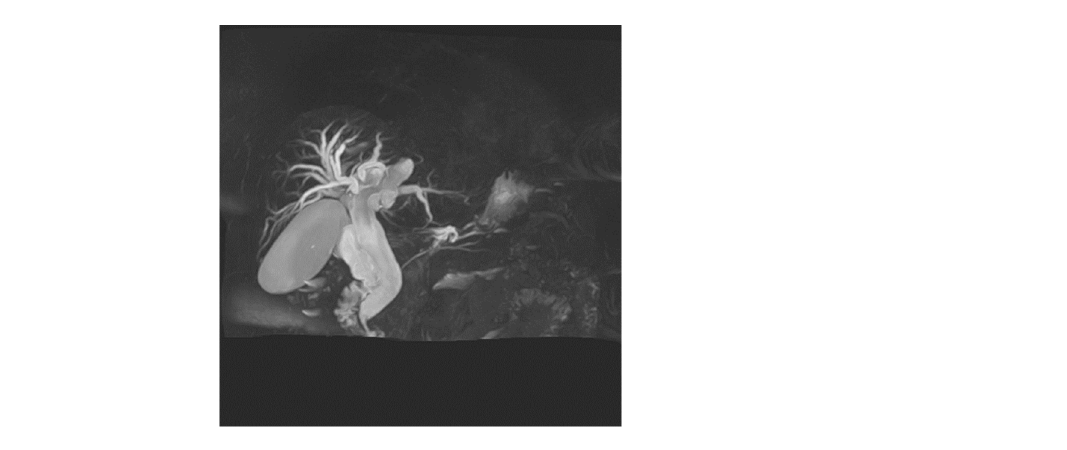
Figure 9. Patient with Common Bile Duct Dilation. MRCP MIP images obtained with a BH-3D- SENSE GRASE sequence. Within a TR, TE of 230, 73 msec, 9 refocusing pulses were applied with 5 gradient-echoes acquired during each echo spacing, resulting in a total scan time of 13 s after parallel imaging acceleration.